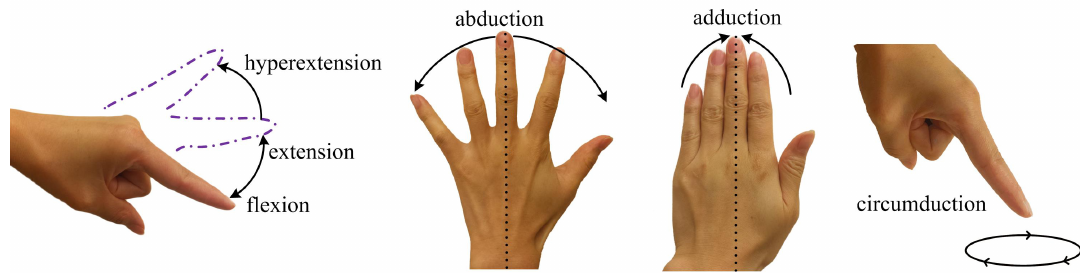
Figure 1. Finger motion: flexion, extension, abduction, adduction, and